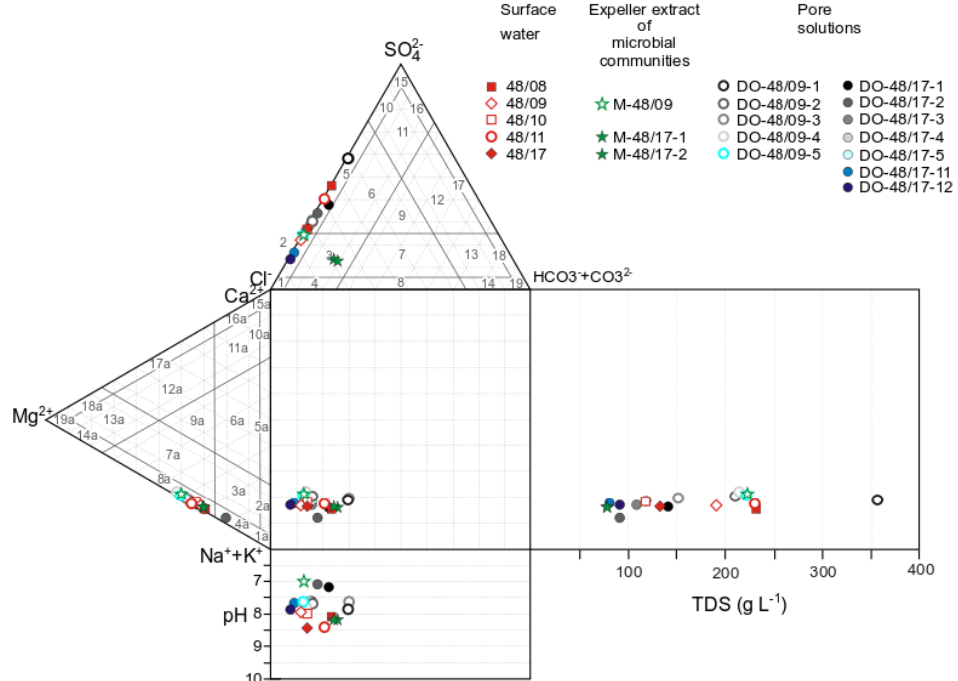
Figure 3. The Durov diagram for surface water, for the expeller extract of microbial communities, and for pore solutions of Lake Solenoe, in combination with the scheme of classification by the profile of the main anions Cl − , SO 42 − , and HCO 3 − and cations Na + +K + , Ca 2+ , and Mg 2+ [27]. Anionic com-